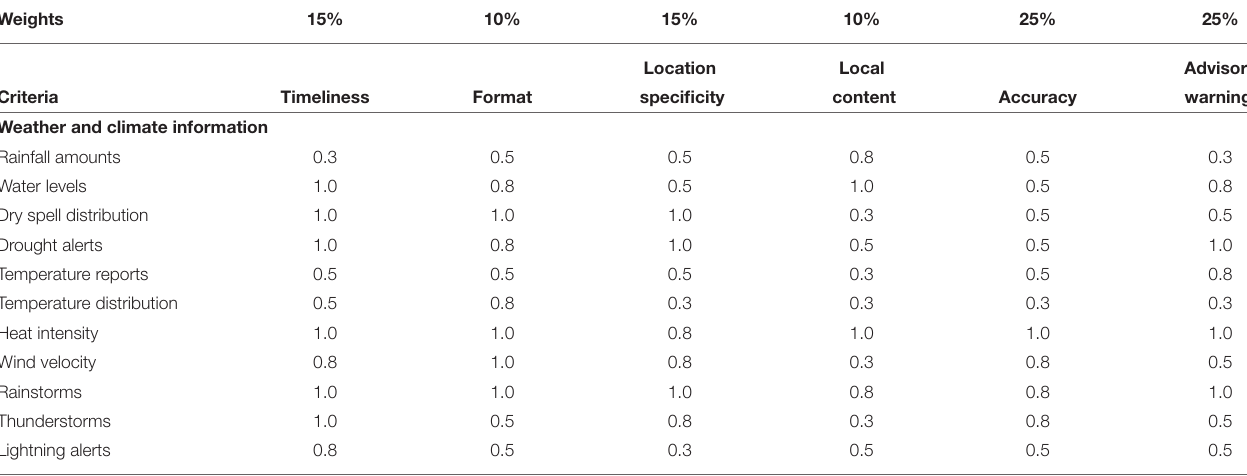
TABLE 10 | Estimates of normalized decision matrix a and relative significances of criteria (criteria weights) (Disaster risk reduction).